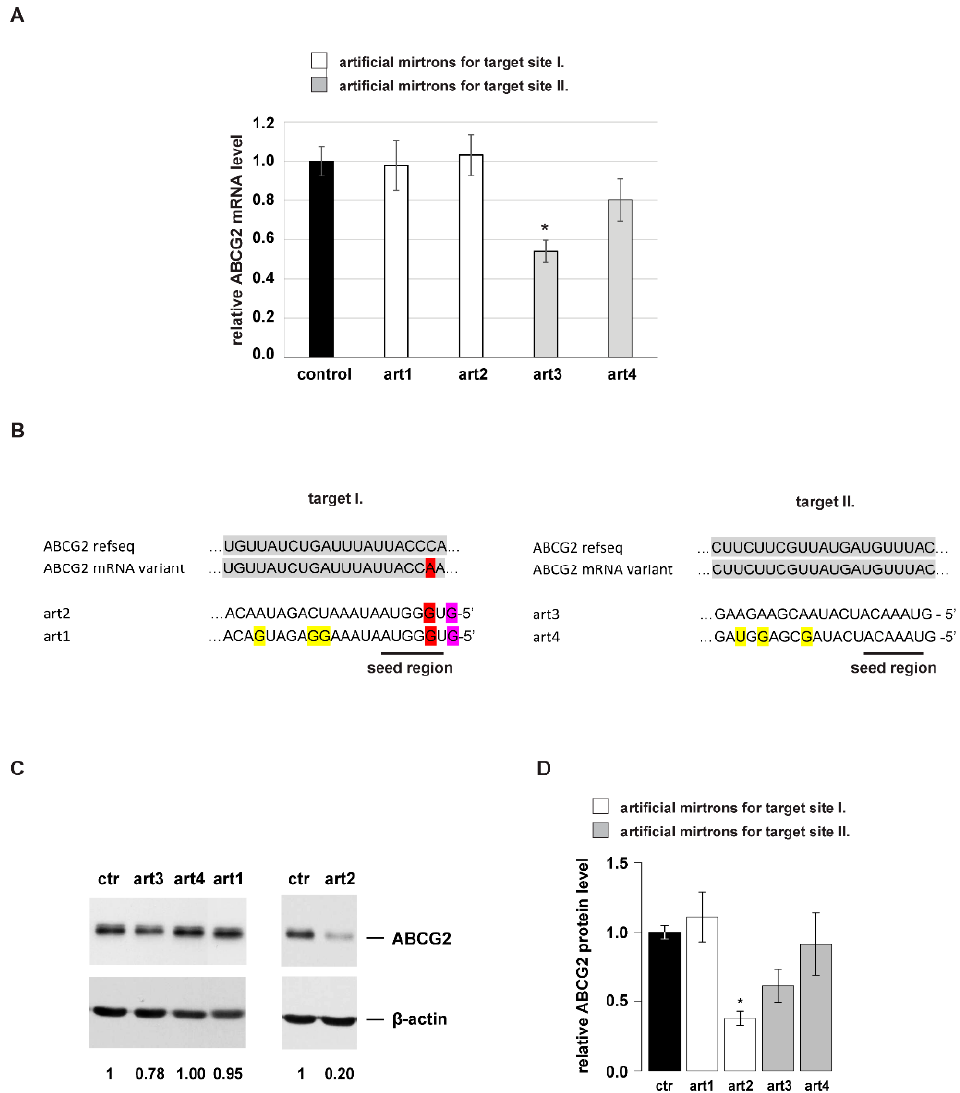
Figure 4. Targeting ABCG2 expression by artificial mirtrons. ( A ) Investigating the mirtron-induced silencing of ABCG2 mRNA by qPCR. Mean values are shown, and error bars represent standard deviations; *: p < 0.005 relative to respective control. ( B ) An illustration of artmirs complementary to the respective ABCG2 mRNA target site. Artmirs were designed based on the reference sequence (NM_004827.3); however, experiments were carried out with a common ABCG2 variant, therefore having a mismatch in target I. sequence (indicated by red background). Purple and yellow backgrounds indicate nucleotides, as in Figure 3A. ( C ) Examination of ABCG2 protein repression by artmirs, a representative western blot experiment is shown; normalized values of ABCG2 protein levels are shown under the gel image. ( D ) Relative protein levels measured after ABCG2 silencing by the artificial mirtron constructs. The mean values of 3 independent experiments are shown for artmirs, and the mean value of 5 independent experiments is shown for control (ctr). Error bars represent S.E.M., *: p < 0.005.